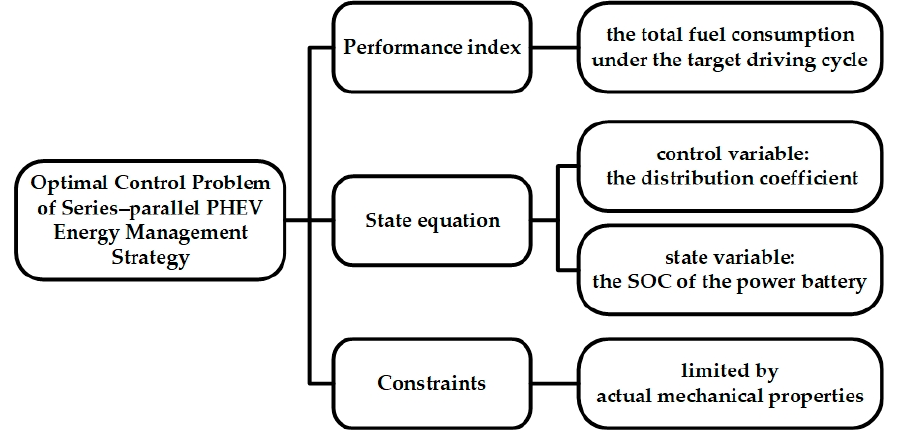
Figure 9. The optimal control problem framework of series-parallel PHEV energy management strategy.